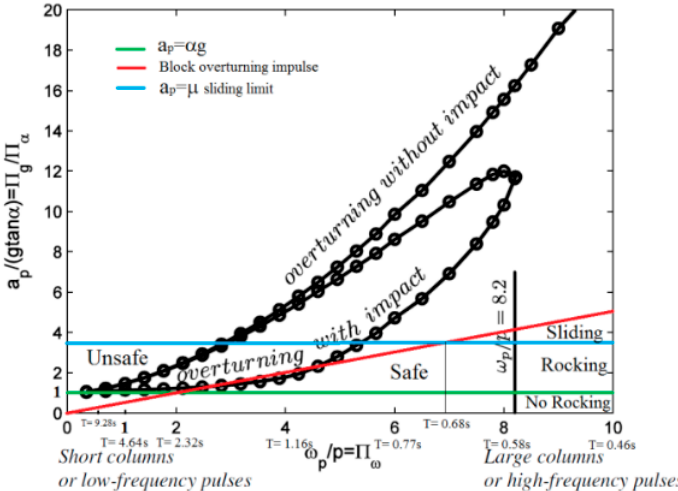
Figure 7. Experimental results for 0.5 m solid cylinder compared to theoretical and UDEC model for 0.5 m block after [79].